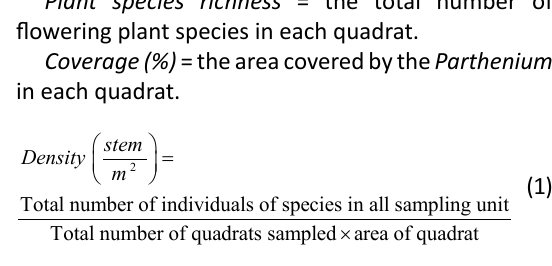
Fig. 2: (A) Occurrence of Parthenium in Kirtipur Municipality; (B) Occurrence of Parthenium across land use types in Kirtipur Municipality